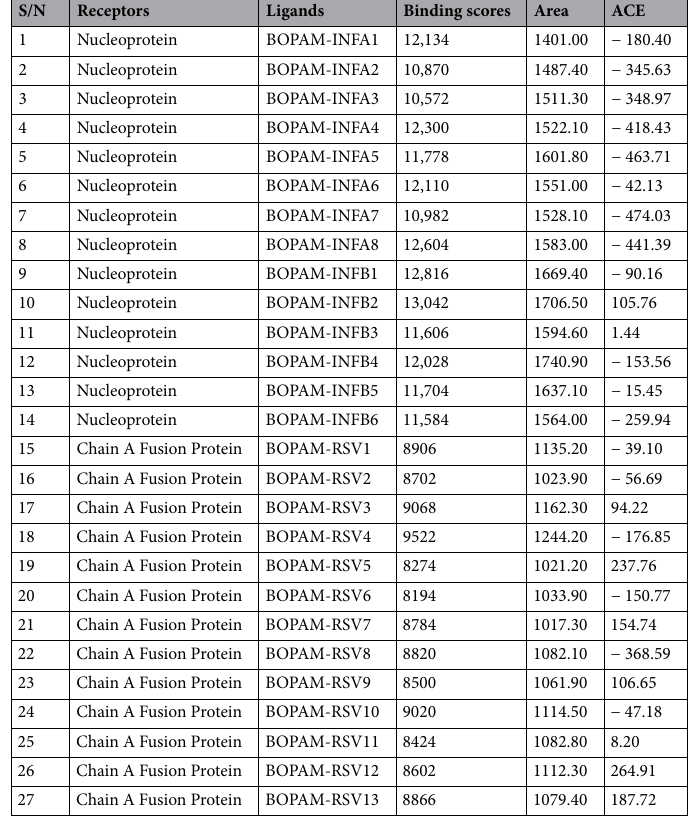
Table 8. Quality assessment scores of the docking analysis for the anti-pneumonia putative AMPs and the pneumonia receptors. S/N serial number, ACE atomic contact